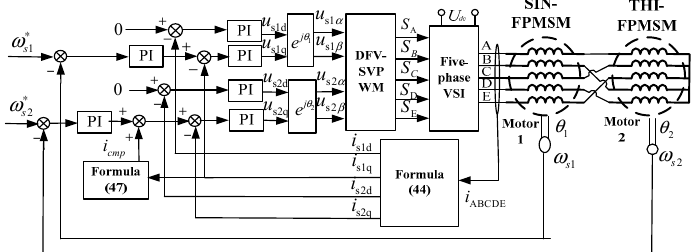
Figure 8. Two kinds of FPMSMS in series decoupling control based on DFV − SVPWM with current compensation.